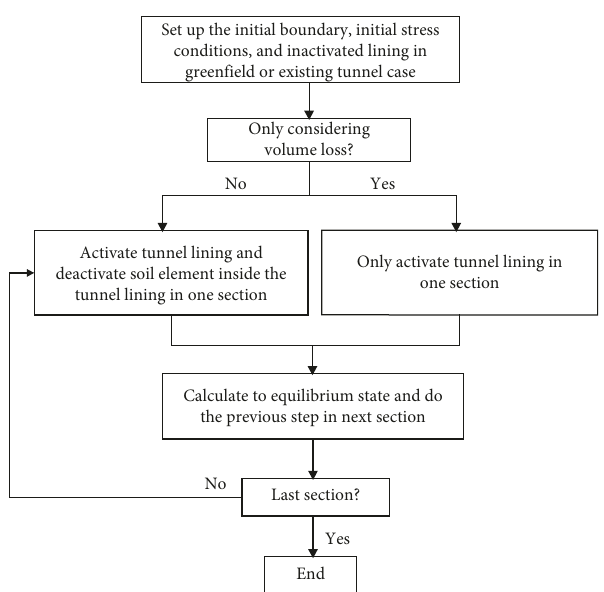
Figure 6: Schematic diagram for the modelling procedure. Offset from new tunnel centre line (m)